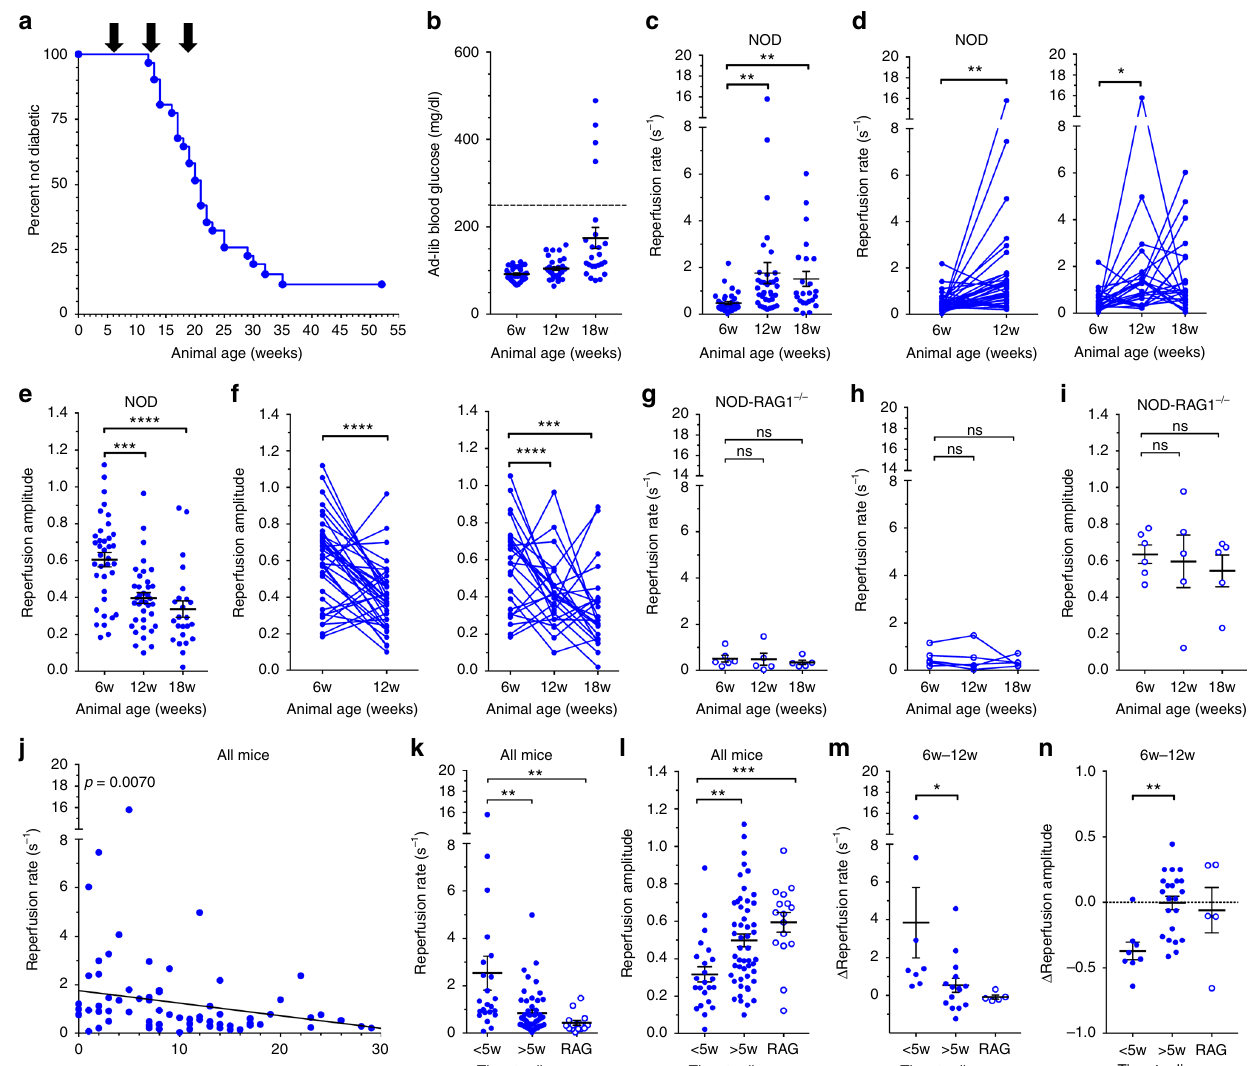
Fig. 3 CEUS non-invasively detects changes in pancreas blood fl ow dynamics associated with the progression of diabetes in NOD mice. a Survival curves indicating time of diabetes onset for all NOD animals analyzed for this study. b Ad lib blood-glucose levels at the time of measurement for all NOD mice. c Reperfusion rate measured in NOD mice at ages indicated. d Data in b showing changes in individual NOD reperfusion rates between 6 and 12 weeks of age (left), or 6 to 18 weeks (right). e As in c for reperfusion amplitude. f As in d for changes in the reperfusion amplitude between 6 and 12 weeks of age (left), or 6 to 18 weeks (right). g Reperfusion rate measured in NOD-RAG1 KO immunode fi cient mice at ages indicated. h Data in g showing changes in individual NOD-RAG1 KO reperfusion rates between 6 and 18 weeks. i As in g for reperfusion amplitude. j Correlations of reperfusion rate with time to diabetes from CEUS scan, in weeks. k Average reperfusion rate over animals that progressed to disease <5 weeks or >5 weeks from CEUS scan, along with measurements in NOD-RAG1 KO mice for comparison. l As in k , for average reperfusion amplitude. m Average change in the reperfusion rate between 6 and 12 weeks averaged over animals that progressed to disease <5 weeks or >5 weeks from CEUS scan, along with average changes in NOD-RAG1 KO mice for comparison. n As in m for change in reperfusion amplitude between 6 and 12 weeks. Error bars represent s.e.m. * p < 0.05, ** p < 0.01, *** p < 0.001, **** p < 0.0001 comparing groups indicated (paired t -test data in d , f , h ; unpaired t -test in k – n ; ANOVA data in c , e , g , i ). Data in a – f represents n = 37 NOD mice ( n = 24 for 18 weeks), data in g – i represents n = 6 NOD-RAG1 KO mice ( n = 5 at 12w, 18w), data in j – l represents 71 scans over 27 NOD mice, data in m , n represents n = 27 NOD mice. A mixed-effects model was used to assess the statistical signi fi cance and generate the regression in